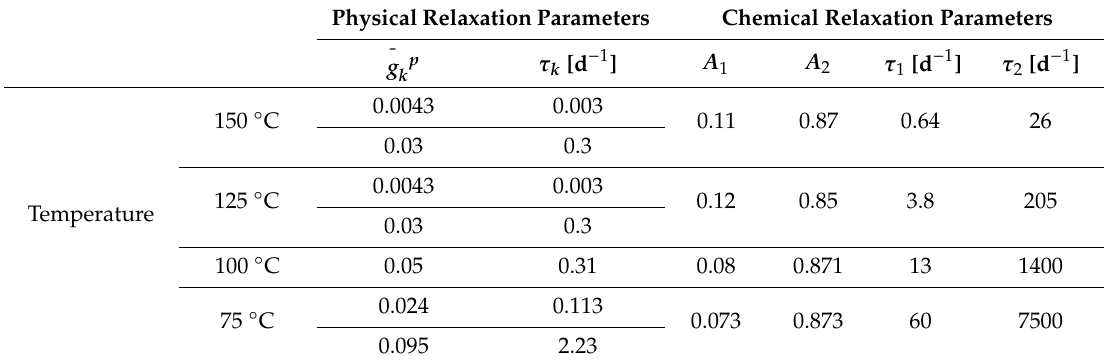
Figure 7. Normalized continuous stress relaxation for EPDM aged at 75 ◦ C, 100 ◦ C, 125 ◦ C and 150 ◦ C (experiment: solid lines, simulation with two first order chemical relaxation processes: dashed lines). Table 2. Set of material parameters for physical and chemical